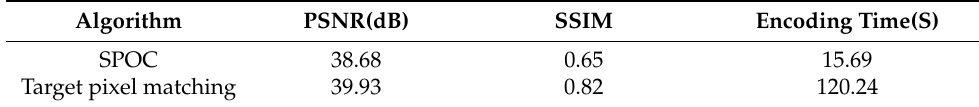
Table 1. Comparison of PSNR and SSIM of the two algorithms in case 1.